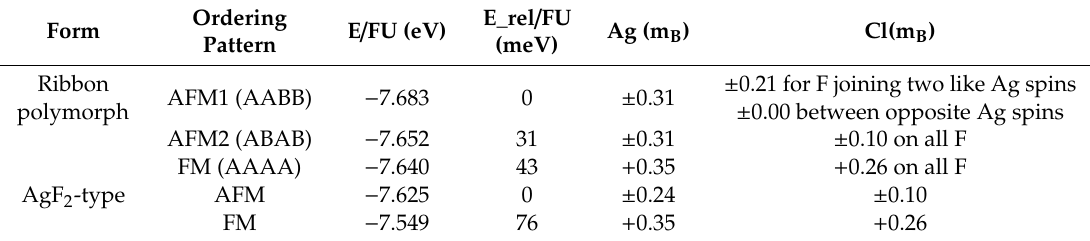
Table 3. Calculated energies, relative energies, and magnetic moments on atoms for the ribbon and AgF 2 -type model of AgCl 2 as calculated using DFT + U + vdW. The unit cell was optimized for the ground state model (AFM1 in a ribbon and AFM in AgF 2 -type structure), while energies of the remaining magnetic models were calculated as single point energies from the ground